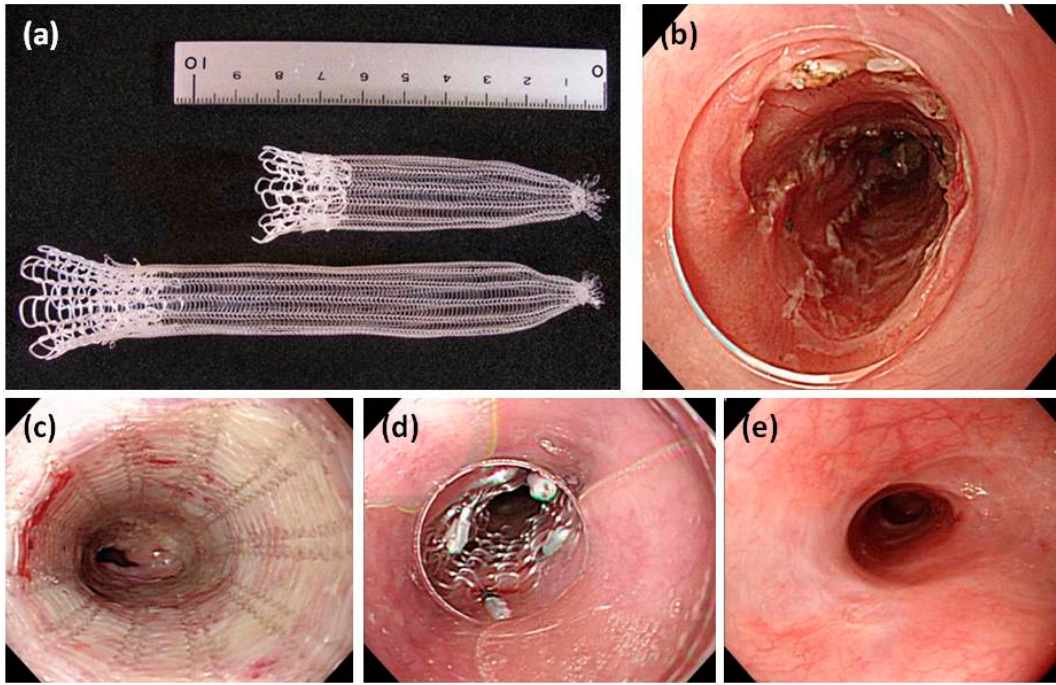
Figure 5. The PLLA esophageal stent (Tanaka–Marui stent; Marui Textile Machinery Co., Ltd., Osaka, Japan) ( a ); the mucosal defect after ESD ( b ); the released PLLA stent ( c ); fixation of the rostral side by endoscopic clips ( d ); and the view at six-month follow-up ( e ) [49]. Copyright permission from Baishideng Publishing Group Inc.